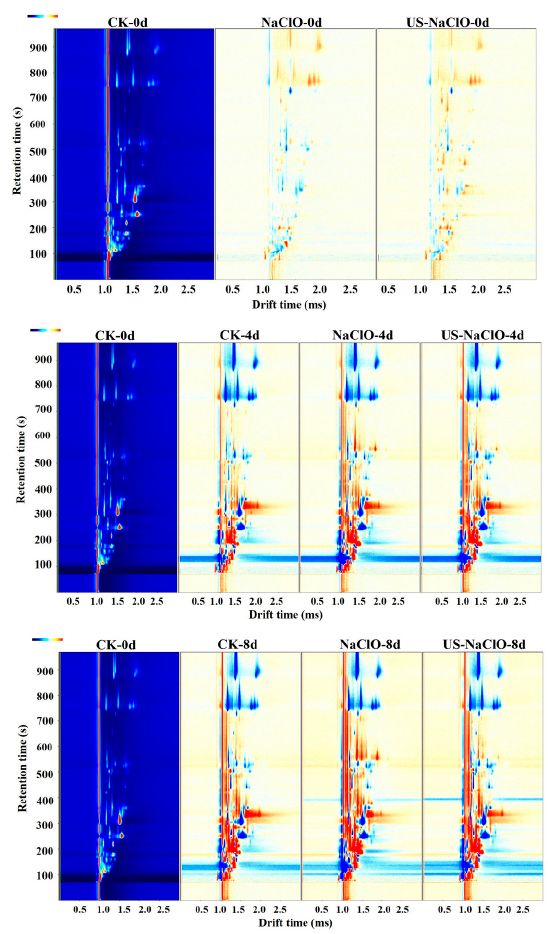
Figure 6. Comparison of the two-dimensional difference spectra of volatile organic compounds GC-IMS in fresh-cut cucumber under different treatments.